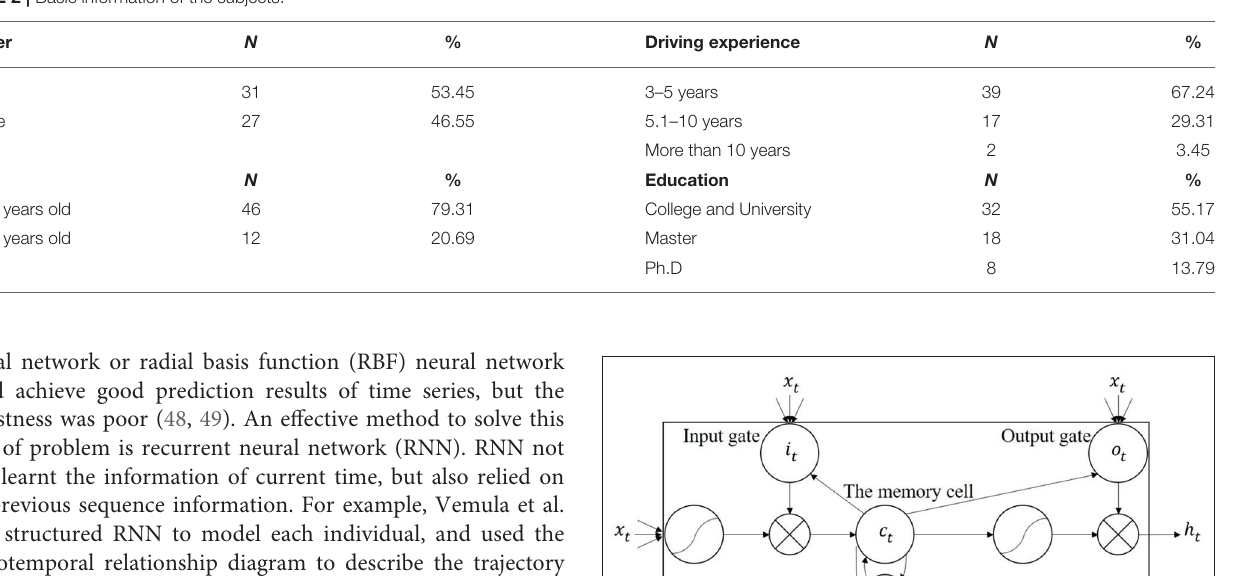
TABLE 2 | Basic information of the subjects.